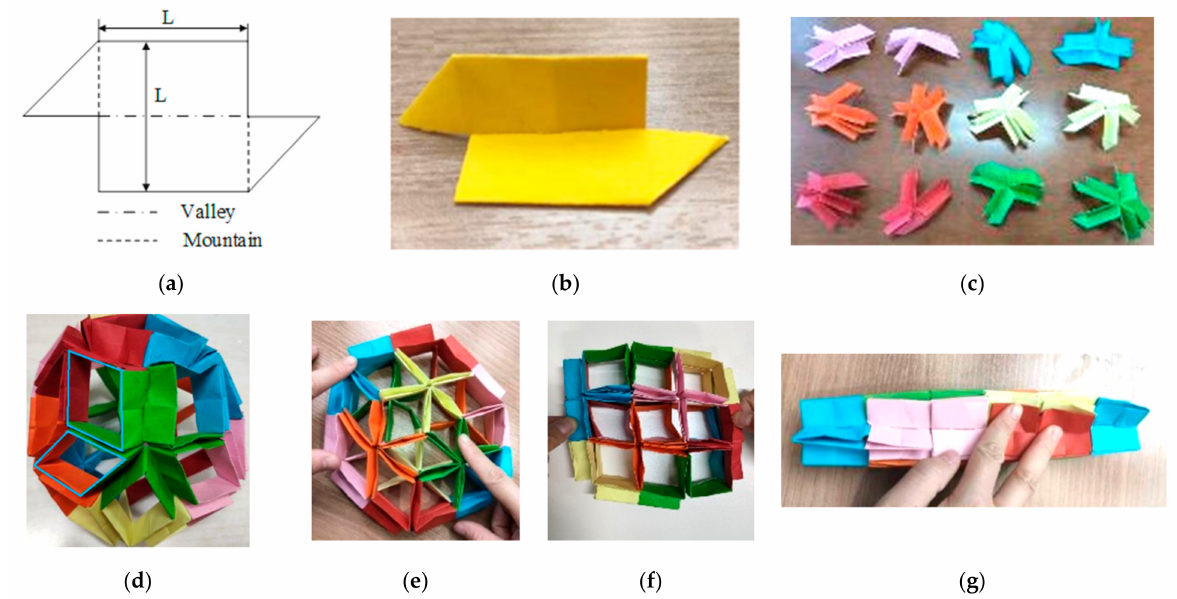
Figure 1. Origami flexiball: ( a ) flat folding pattern, ( b ) modular unit sheet, ( c ) snapping modular units, ( d ) flexible triacontahedron with extruded outward rhombic faces, ( e – g ) some kinds of switchable ultimate